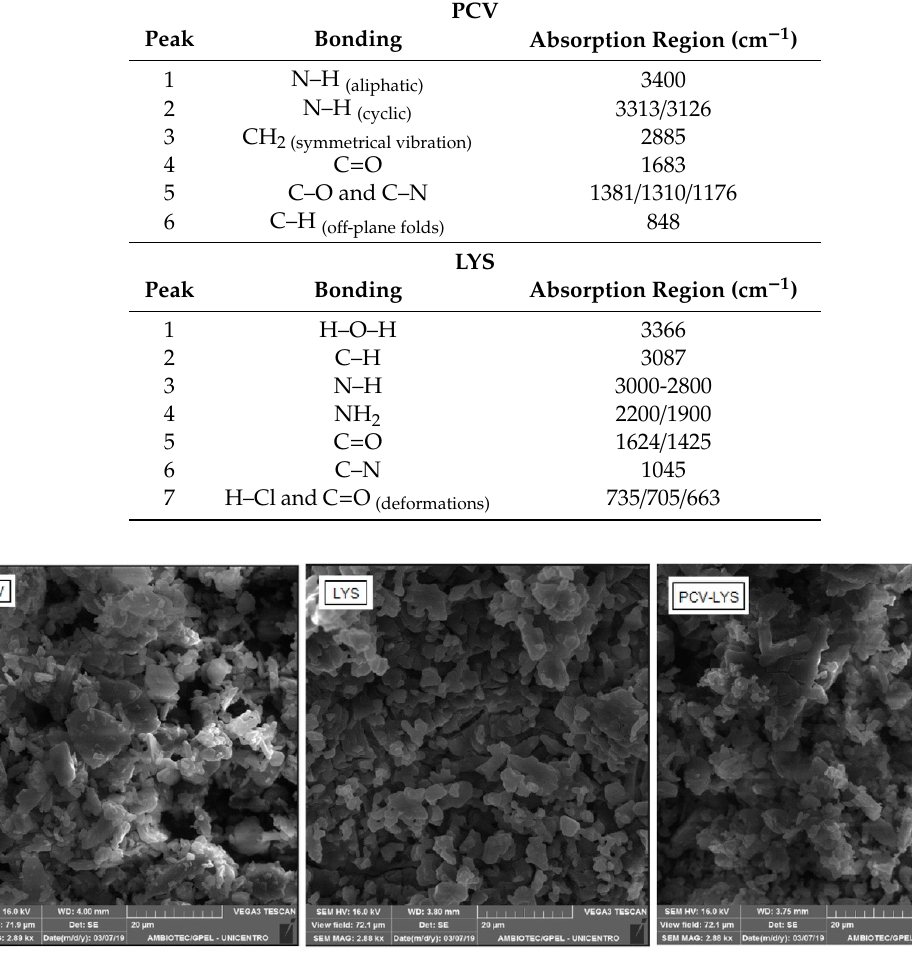
Table 2. T peak temperatures of the main event in the DSC curves of PCV, LYS, and binary and ternary